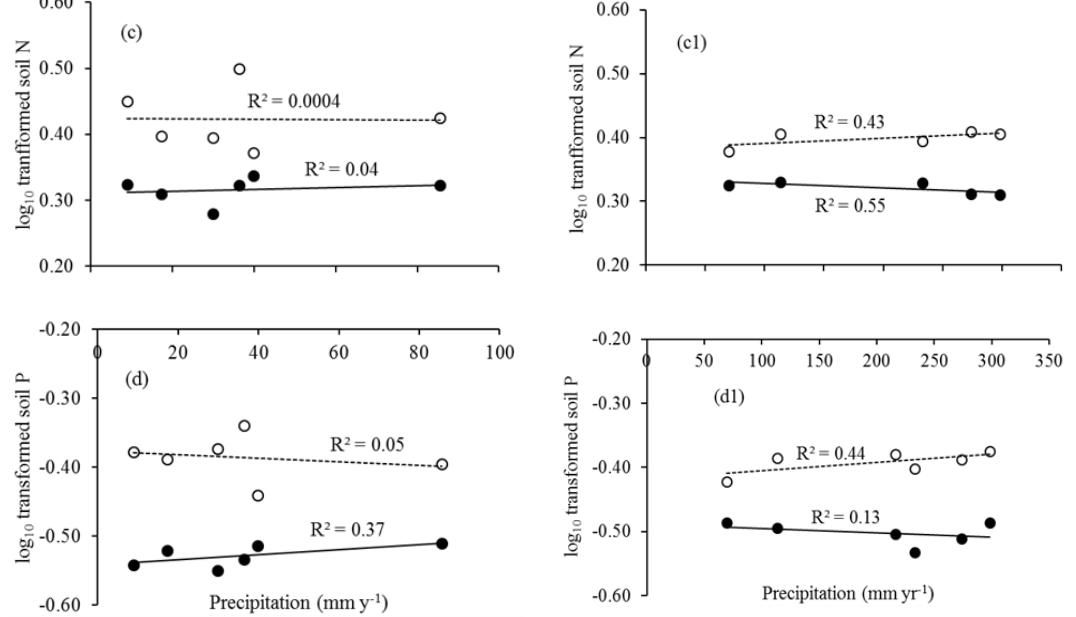
Figure 4. Leaf litter N ( a , a1 ) and P ( b , b1 ), and soil N ( c , c1 ) and P ( d , d1 ) in the ( i ) dry and ( ii ) rainy season. Solid trend lines represent the site PTF and dotted lines the site STF.